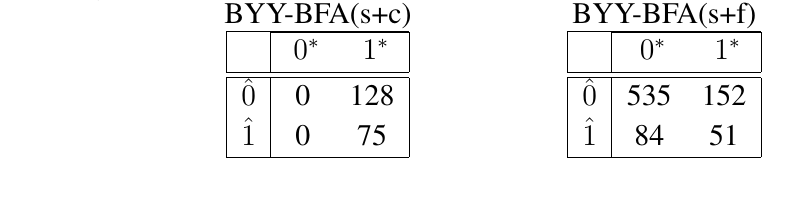
Figure 2: The estimated TFA profiles on Yeast cell-cycle data by the algorithms in Tab. 1. Table 3: Confusion matrices of the reconstructed connectivity by sparse BYY-BFA on yeast cell- cycle data against the known connectivity from available experiments. For sparse BYY-BFA, a connection is determined to be present if the absolute value of its estimated control strength is larger than a threshold 0 . 02 . Notations: ^0 or ^1 denotes reconstruction, 0 (cid:3) or 1 (cid:3) denotes the known